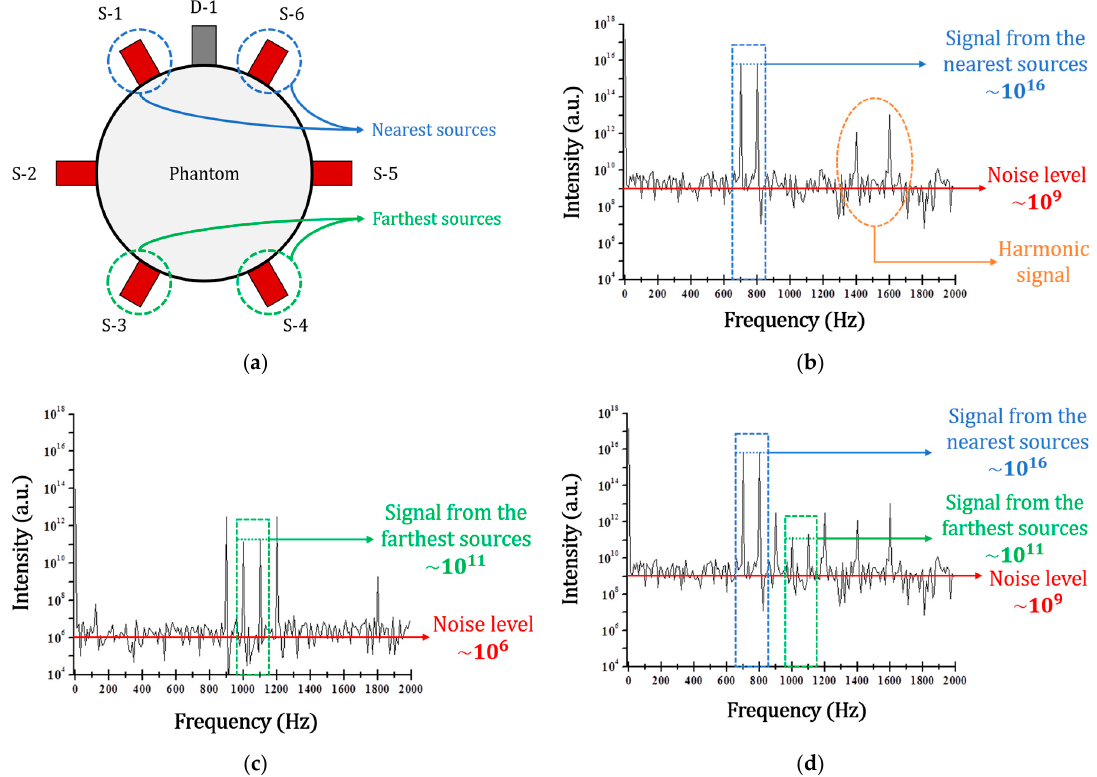
Figure 6. ( a ) Schematic setup of experiment, ( b ) FFT result when turned on the only the nearest two sources of S-1 and S-6, ( c ) FFT result when turned on far four sources of S-2, S-3, S-4, and S-5, ( d ) FFT result when turned on all of 6 sources.